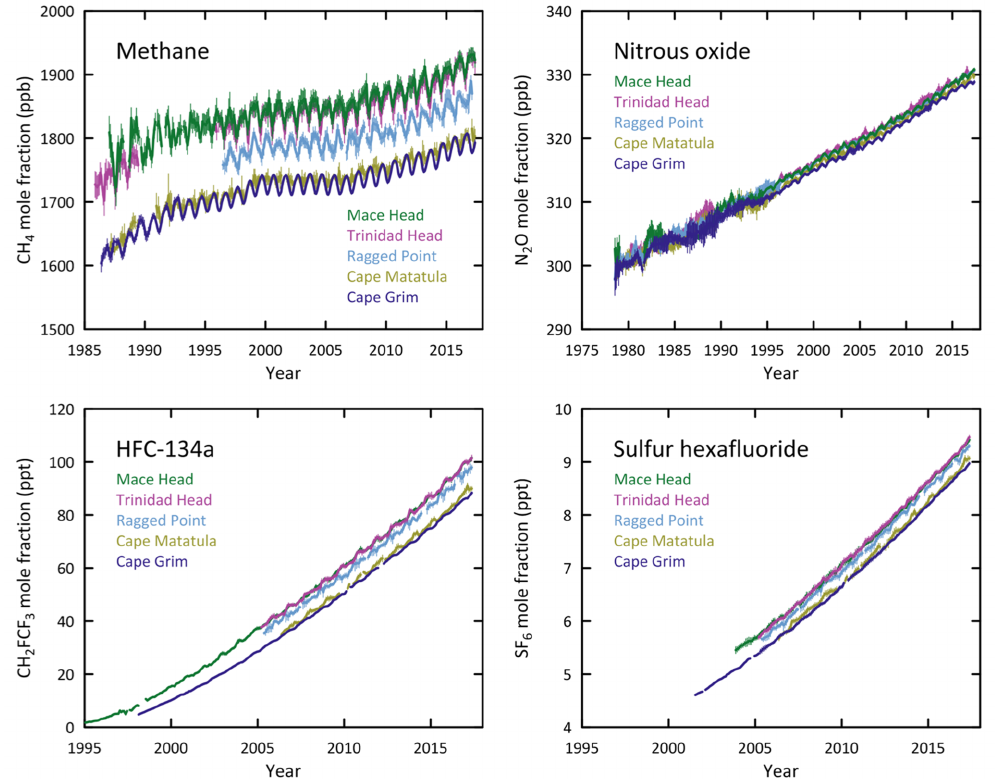
Figure 5. Monthly mean mole fractions and standard deviations for selected Kyoto Protocol gases through